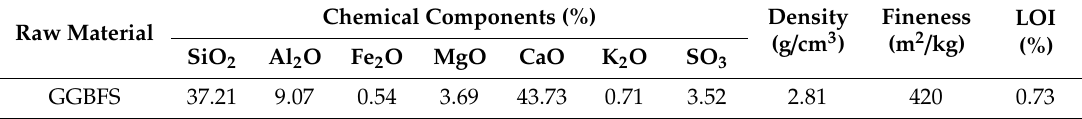
Table 1. Properties of